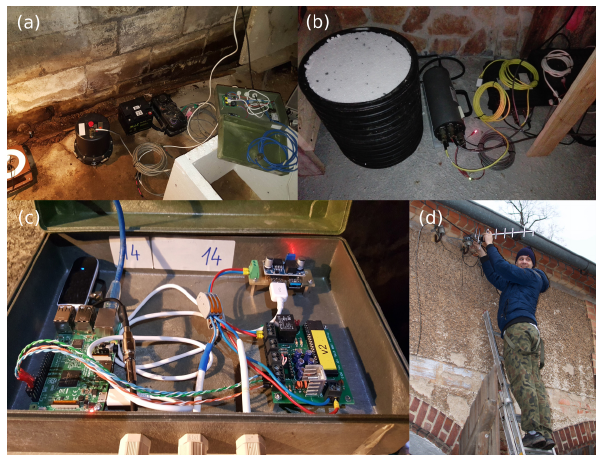
Figure 3. Deployment of seismic stations in the Sudetes: (a) Reftek unit during installation, (b) installed Güralp unit, (c) data- transmission module – Raspberry Pi microcomputer with UMTS modem and watchdog, (d) installing the UMTS antenna for data